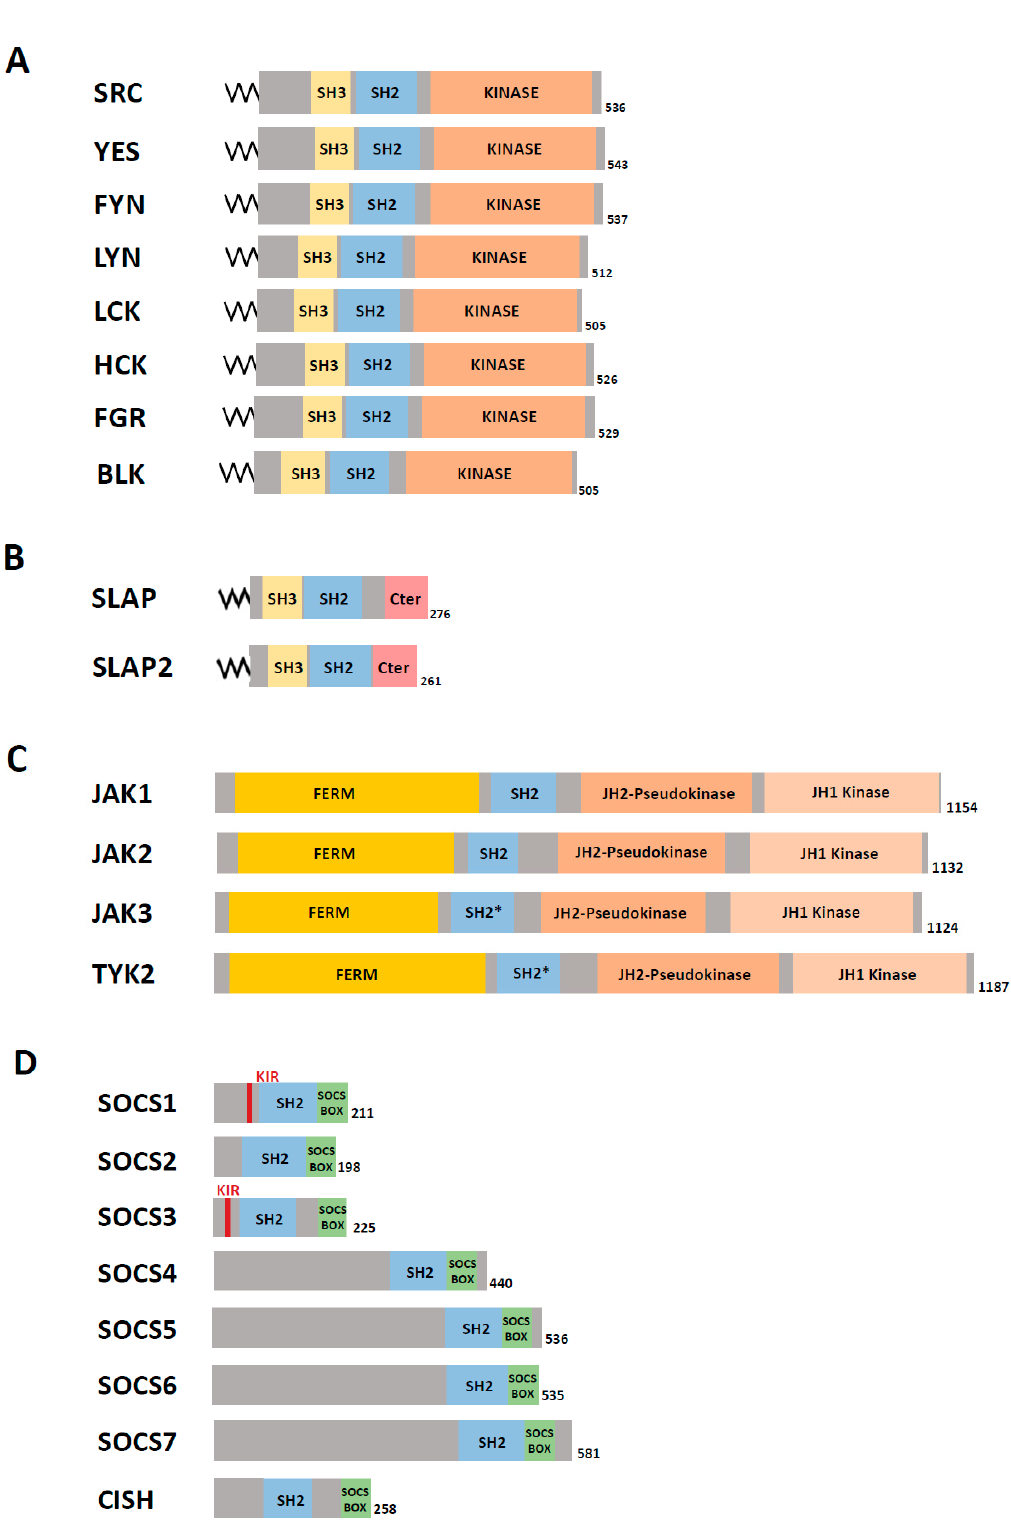
Figure 2. Modular structure of the SRC and Janus kinase (JAK) families of CTKs and of the Src-like adaptor protein (SLAP) and suppressor of cytokine signalling (SOCS) families of TK adaptors. Modular structure of the SRC ( A ), SLAP ( B ), JAK ( C ) and SOCS ( D ) families. The length (number of amino acids), specific homology domains (kinase inhibitory region (KIR); SRC Homology 2 (SH2); SH3; atypical SH2 domain SH2*; FERM, kinase domain JH1; pseudokinase JH2; SOCS BOX) and lipid acylation sites (/\/\) are indicated.